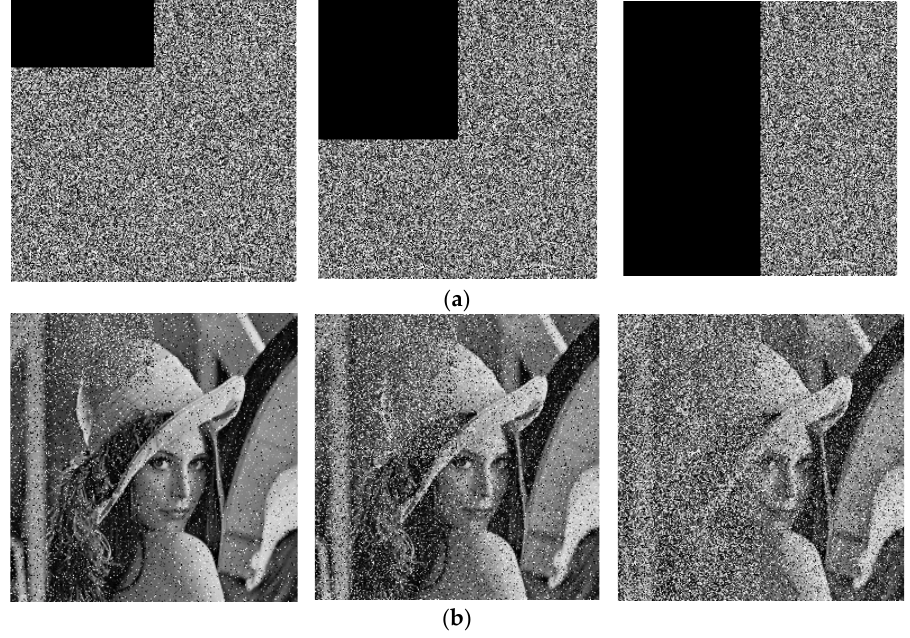
Figure 11. The results of a cropping attack: ( a ) cipher images with 1/8, 1/4, and 1/2 data loss; ( b ) decrypted images of ( a ).